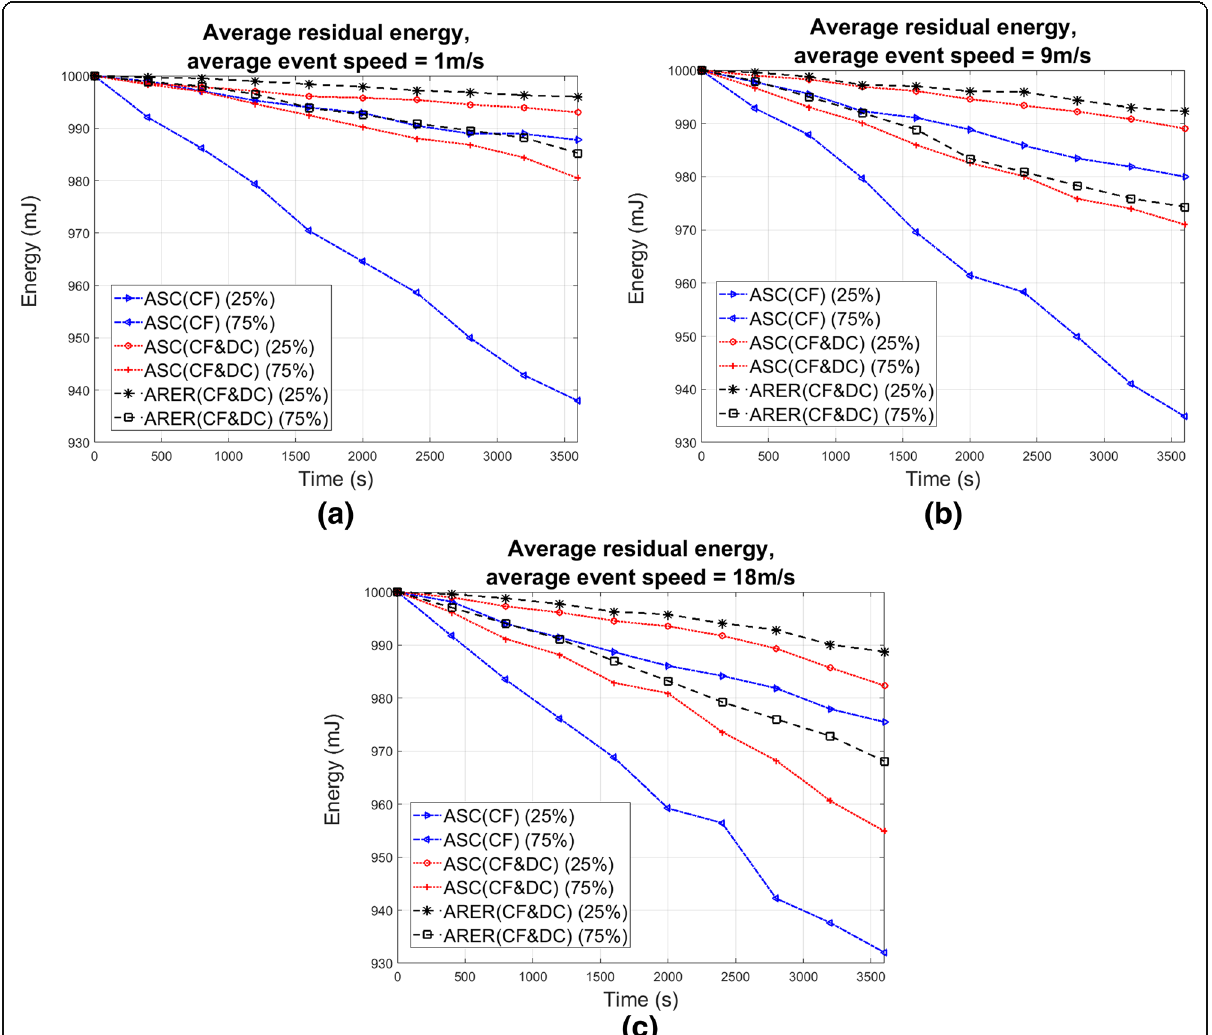
Fig. 4 Average residual energy of the network with different speeds of the event. a Average event speed 1 m/s. b Average event speed 9 m/s. c Average event speed 18